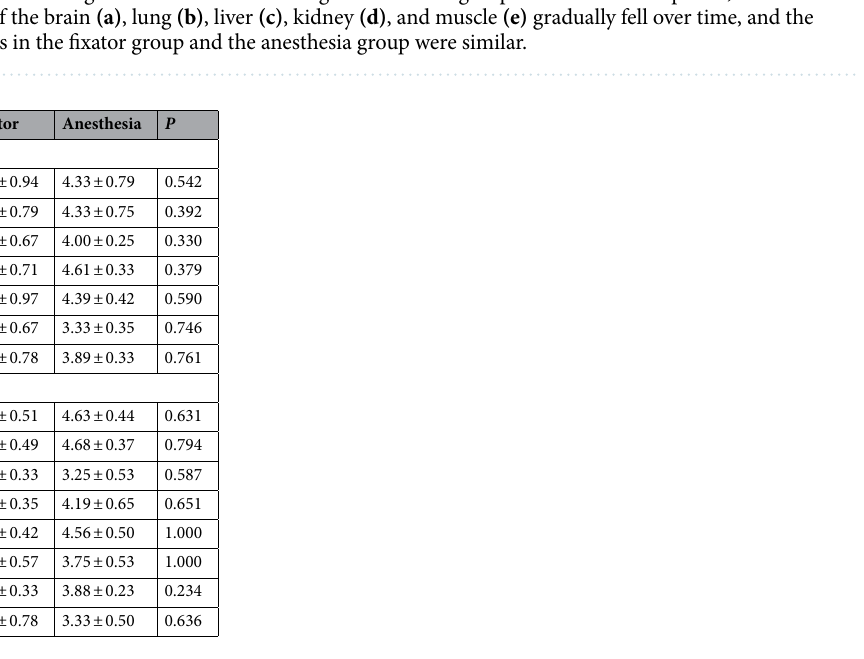
Table 2. Comparison of the subjective image quality of the CT, MRI and PET images of the two groups (